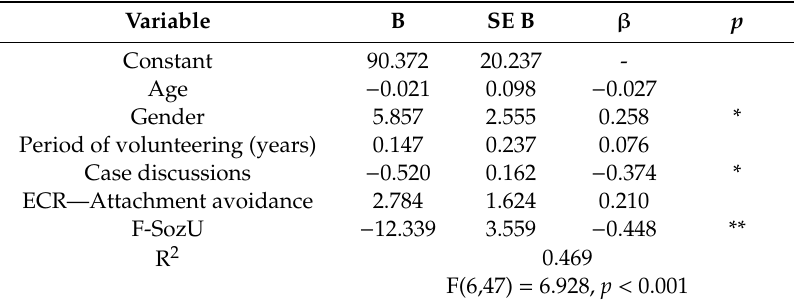
Table 5. Regression analyses for predictors of secondary